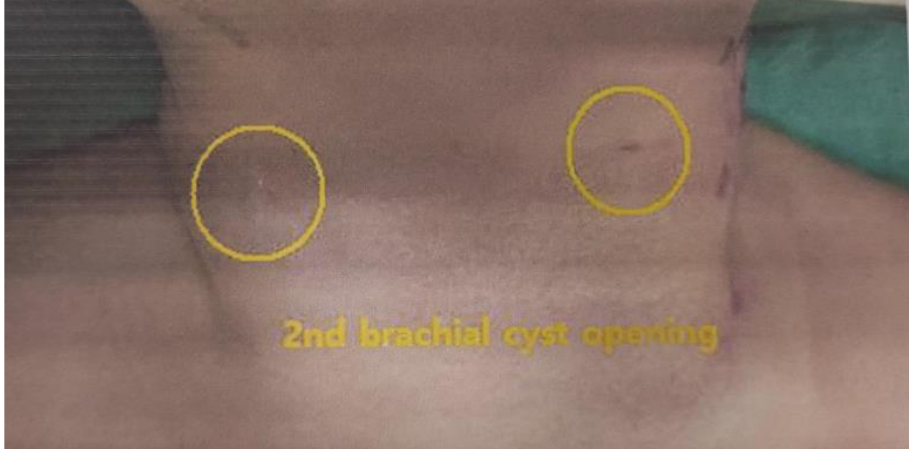
Figure 2. Bilateral second branchial cysts and fistulas opening.